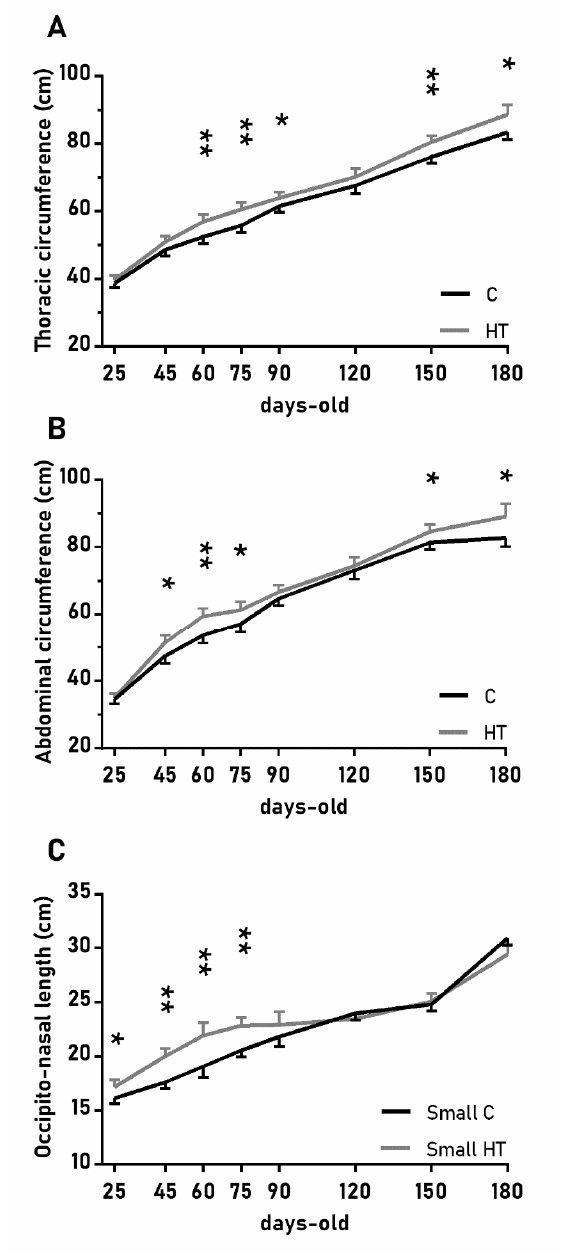
Figure 3. Highlight of significant di ff erences between pigs born from sows treated or not with hydroxytyrosol during pregnancy (groups HT, grey line, and C, black line, respectively) in the mean values ( ± S.E.M.) of the thoracic and abdominal circumferences respectively ( A ) and ( B ), for pigs from litters of small size ( < 8 piglets), the occipito-nasal length ( C ) from weaning at 25 days-old to 180 days-old. Asterisks indicate significant di ff erences between groups (*: p < 0.05, **: p < 0.01).